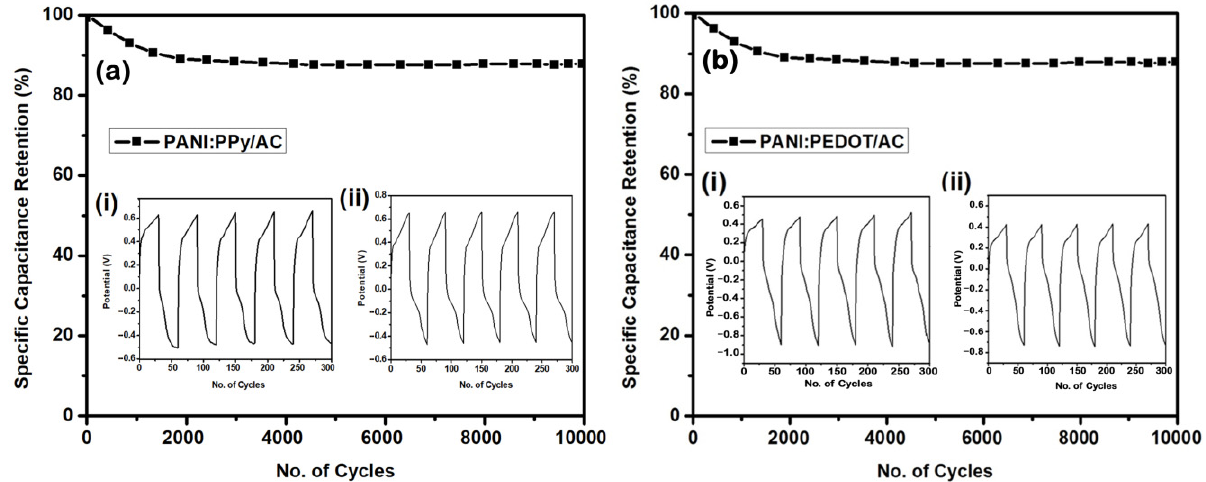
Figure 10. Cyclic stability curve of PANI:PPy/AC and PANI:PEDOT/AC composite for 10,000 cycles. The inset shows the first (( a , b ) ( i )) and last five cycles (( a , b ) ( ii )) for the composites.